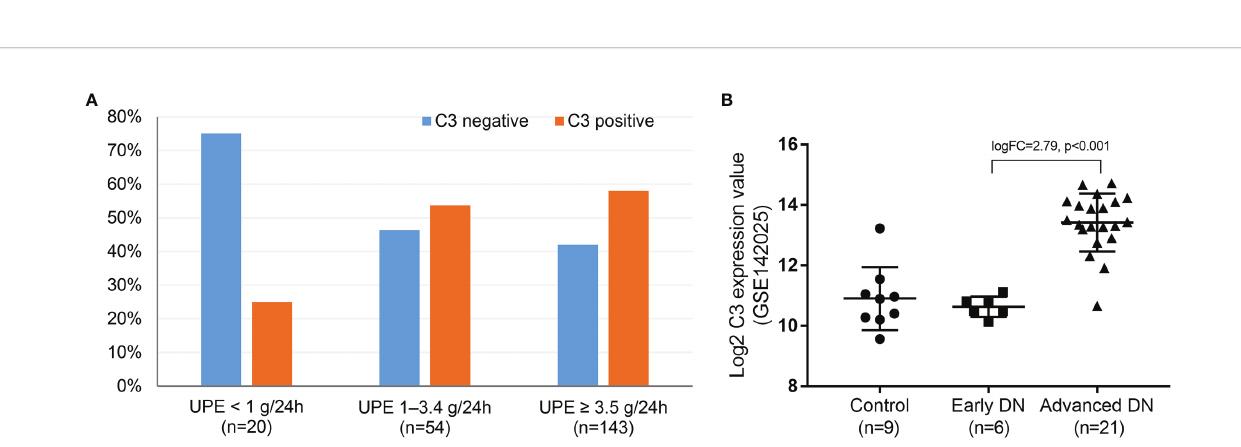
FIGURE 7 | Direct immuno fl uorescence for the proportion of C3 deposits at different proteinuria levels in DN (A) and RNA sequencing analysis of C3 from the whole-kidney tissues of patients with early and advanced DN compared with nephrectomy sample tissues from those without diabetes (B) . DN, diabetic nephropathy. Early DN was de fi ned as urinary albumin-to-creatinine ratio (UACR) between 30 and 300 mg/g and estimated glomerular fi ltration rate (eGFR) >90 ml/ min/1.73 m 2 . Advanced DN was de fi ned as UACR >300 mg/g and eGFR <90 ml/min/1.73 m 2 . The control human kidney samples were obtained from the unaffected portion of tumor